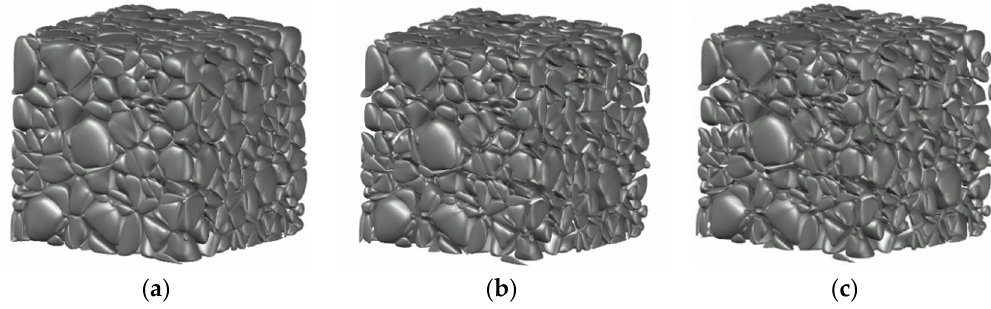
Figure 3. RAM distributions of cubic fully graded concrete samples during scaling procedures. ( a ) After scaling of the 80–150 mm group, ( b ) after scaling of the 40–80 mm group, and ( c ) after scaling of the 20–40 mm group.